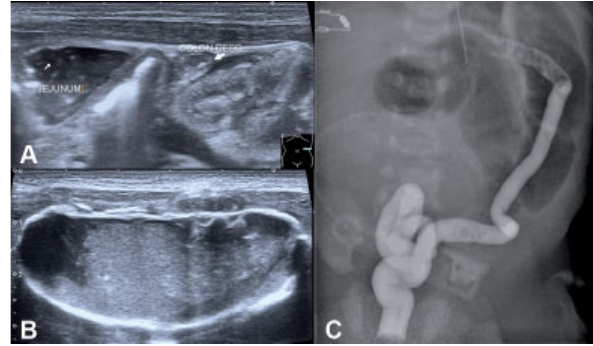
Fig. 2 Ultrasound and contrast enema. ( A ) Ultrasound of the meconium pseudocyst with an echogenic rim and heterogenous content. ( B ) In the left abdomen were grossly distended intestinal loops, the descending colon appears empty. ( C ) Contrast enema shows an unused